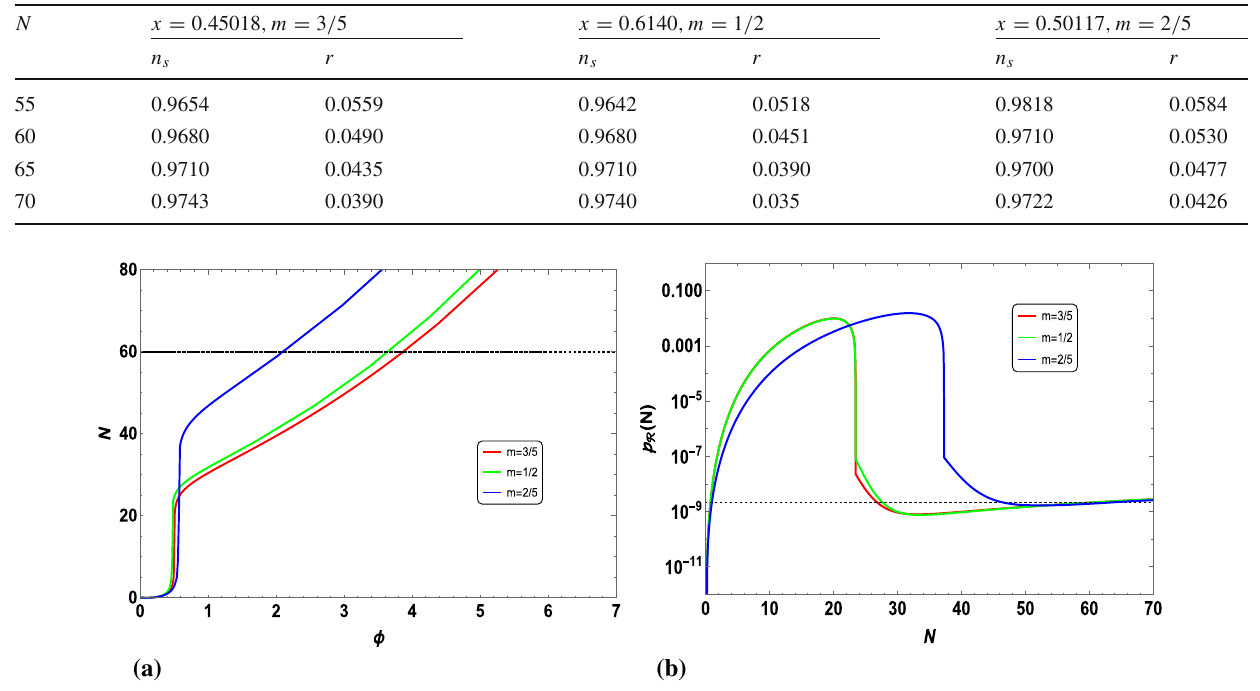
corresponds to x = 0 . 45018, green is for x = 0 . 6140 and blue stands for x = 0 . 50117. Peak in the P R can be seen clearly which is necessary for the production of the PBHs. The black dotted line shows the value of P R ( = 2 . 1 × 10 − 9 ) at large scales and it is in good agreement with the Planck (cid:3) 18 [55]. Enhancement in the power spectrum is calculated numerically using Eq. (5)